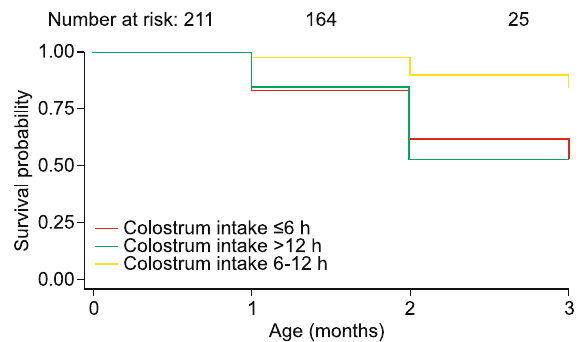
Fig. 1 K-M survival curve of all-cause morbidity in lamb based on colostrum intake